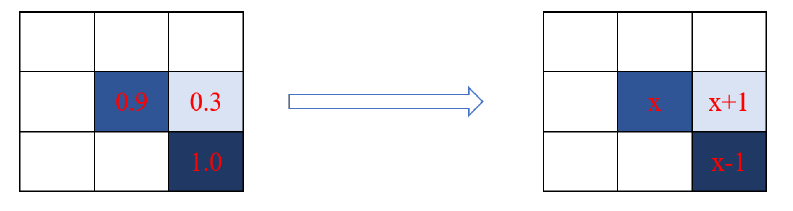
Figure 3. The concentration in the grid corresponding to positions in the diffusion